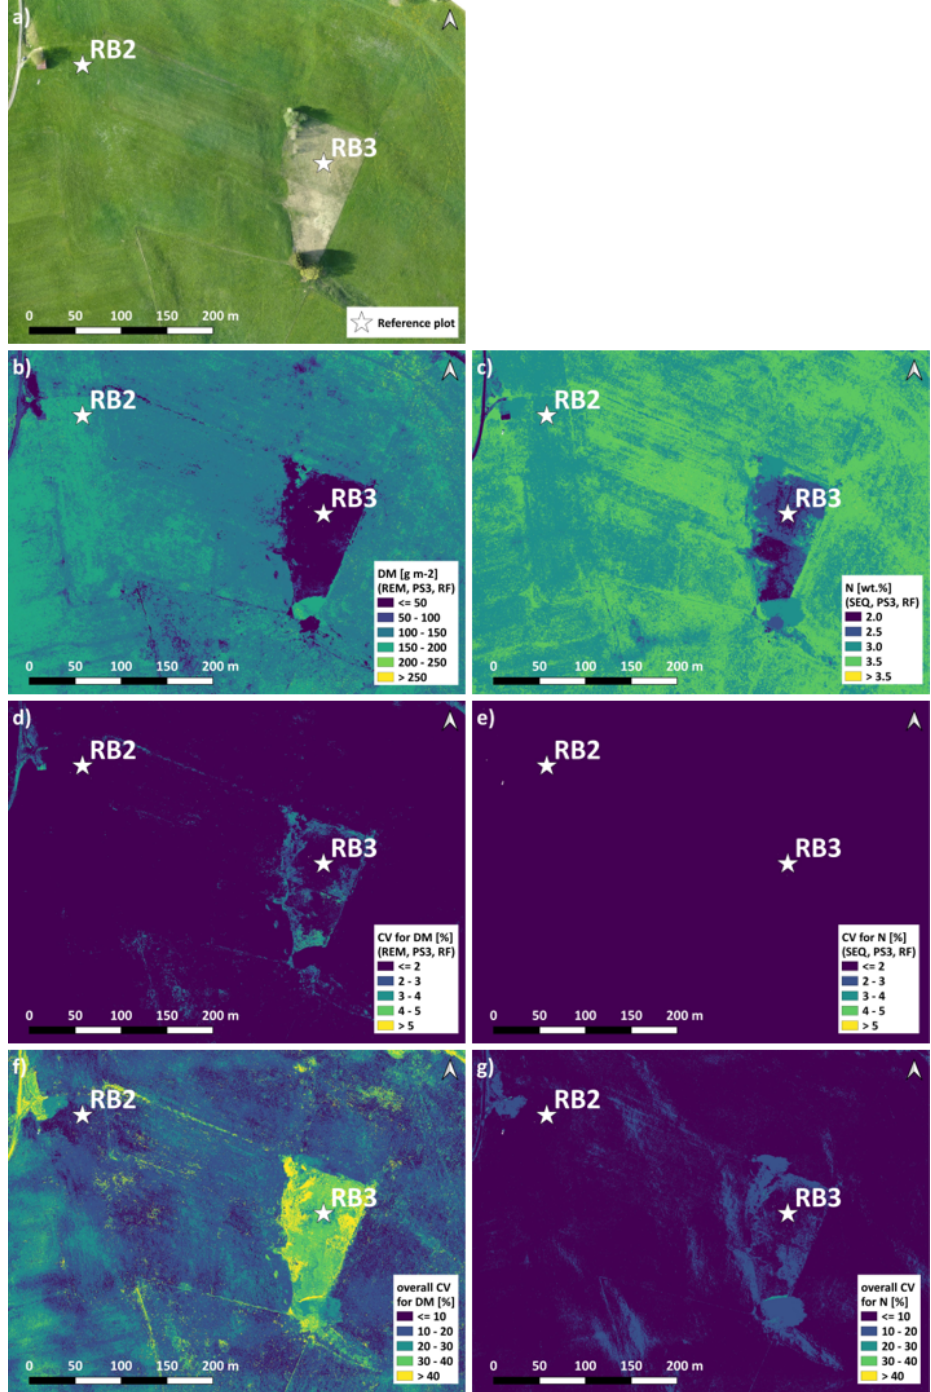
Figure 9. Spatial estimation at the RB-North site. (a) Orthophoto for comparison. (b) DM with an REM–PS3–RF combination (best spatial prediction). (c) N concentration with an SEQ–PS3–RF combination (best spatial prediction). (d) CV of DM with an REM–PS3–RF combi- nation. (e) CV of N concentration with an SEQ–PS3–RF combination. (f) Overall CV of DM for all PS1 and PS3 models. (g) Overall CV of N concentration for all PS1 and PS3 models. Predictor set PS3: raw reflectance data + VI. Estimation of DM and N concentration represents the mean of the 10 iterations for the selected model. Note that spatial estimates are only valid for pixels of unshaded and vegetated grassland.